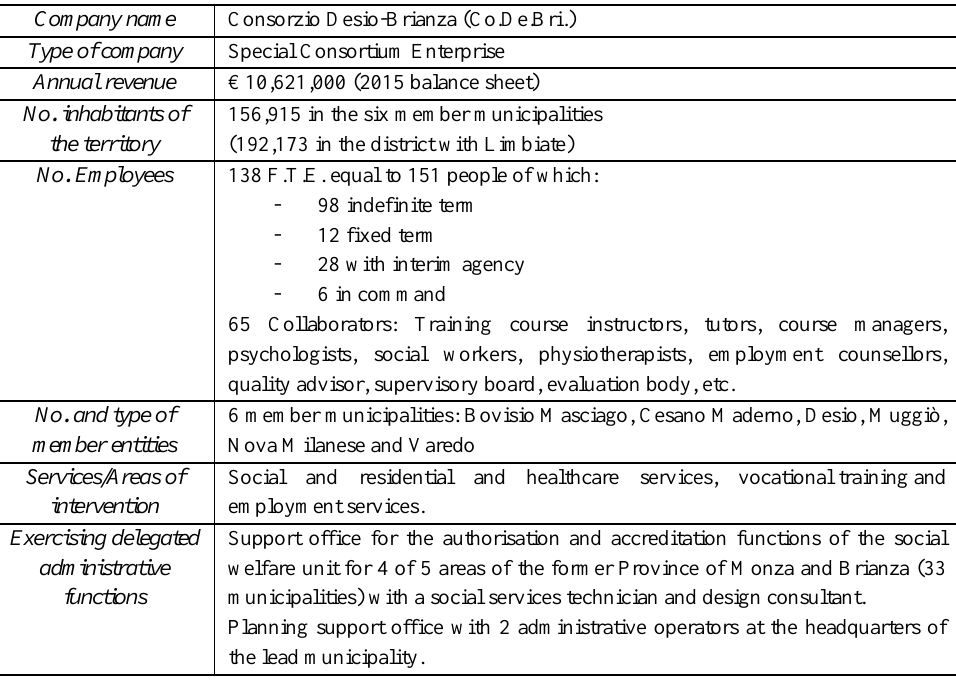
Table 1: Co.De.Bri.